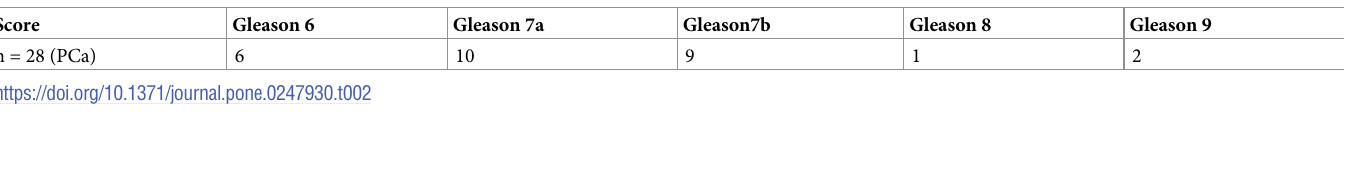
Table 2. Gleason-scores of the study